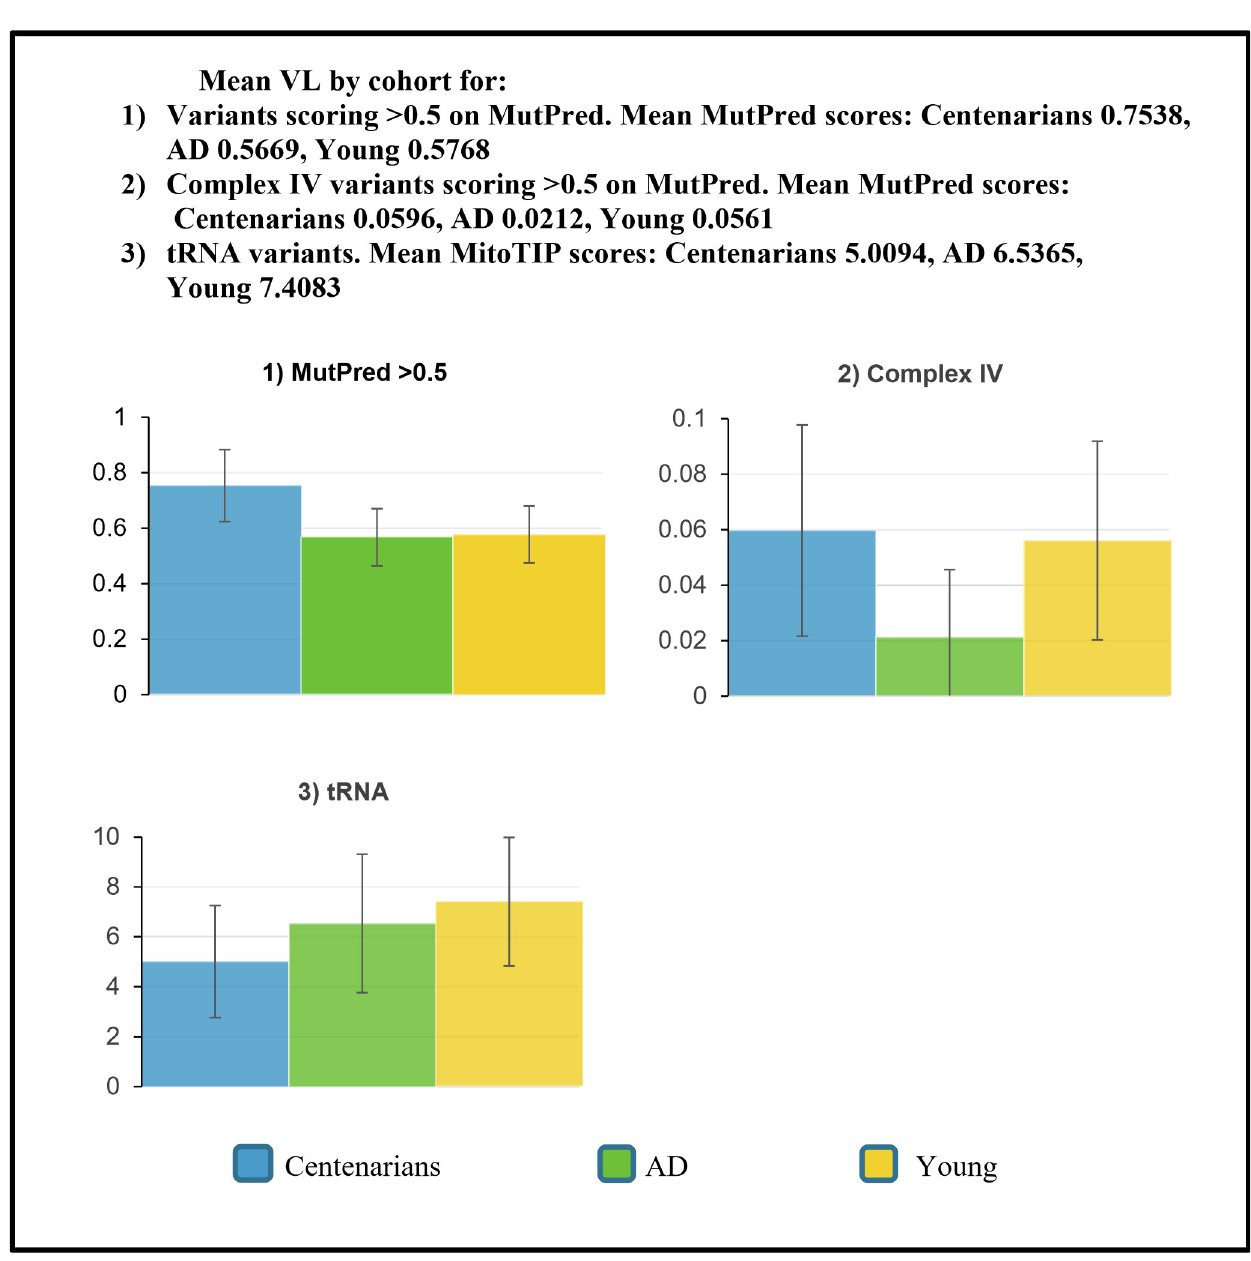
Fig 1. Means and 95% confidence intervals of variant loads calculated using MutPred. All genes variants scoring > 0.5 on MutPred (top left), variants scoring > 0.5 on MutPred affecting Complex IV (top right) and MitoTIP tRNA variants (bottom left).